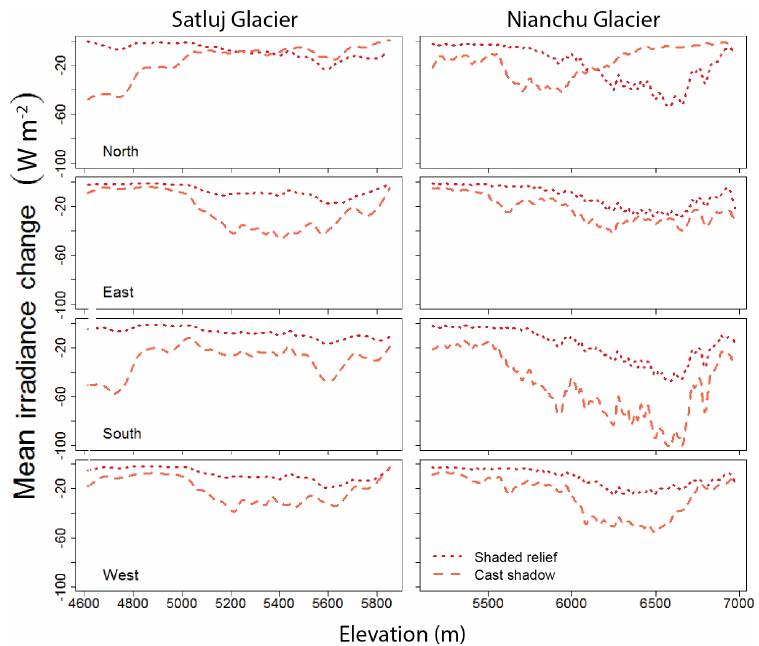
Figure 6. Idealized scenarios for Satluj and Nianchu glaciers. Mean change in irradiance throughout the summer melt season due to shaded relief and cast shadows. Glaciers have been rotated in the four main cardinal directions to observe how shading changes with differing valley aspect. The difference between shaded relief and cast shadows is largest at lower and mid-elevations for the north and south valley direction. Also note that shaded relief is only greater than cast shadowing in the upper elevations of the north-facing direction for both